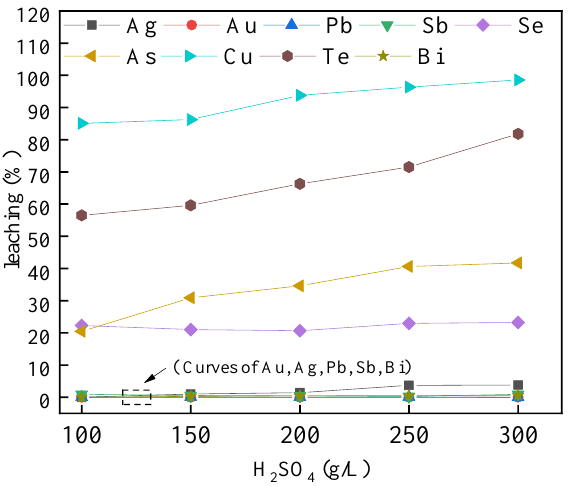
Figure 5. Effect of sulfuric acid concentration on leaching of each element (T = 150 °C, P = 0.8 MPa and t = 2 h).